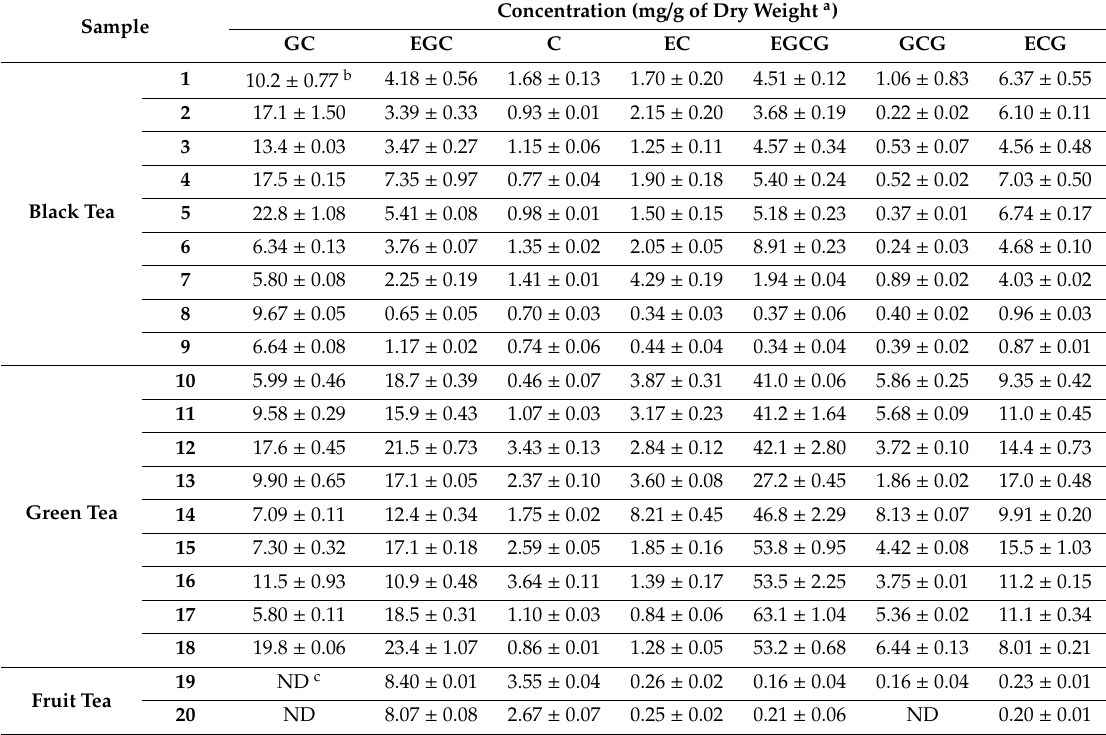
Table 1. Content of catechins determined in leaves of tea